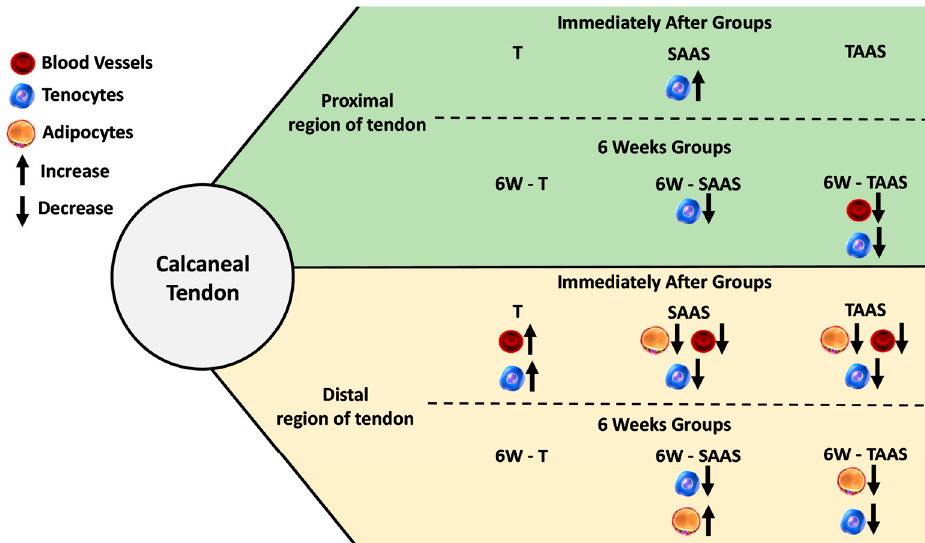
Figure 6. Overview of main results acquired during this study, showing that AAS promoted harmful effects on tendon tissue morphology mainly in distal